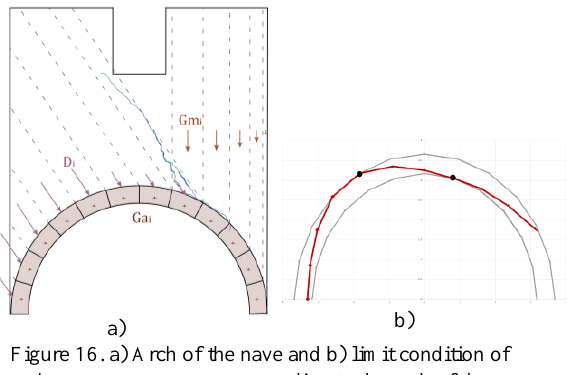
Figure 17. Test of the façade overturning, with calculation of the safety factor γR